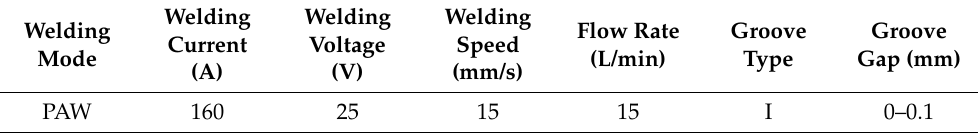
Table 2. Welding parameters used in the welding process.